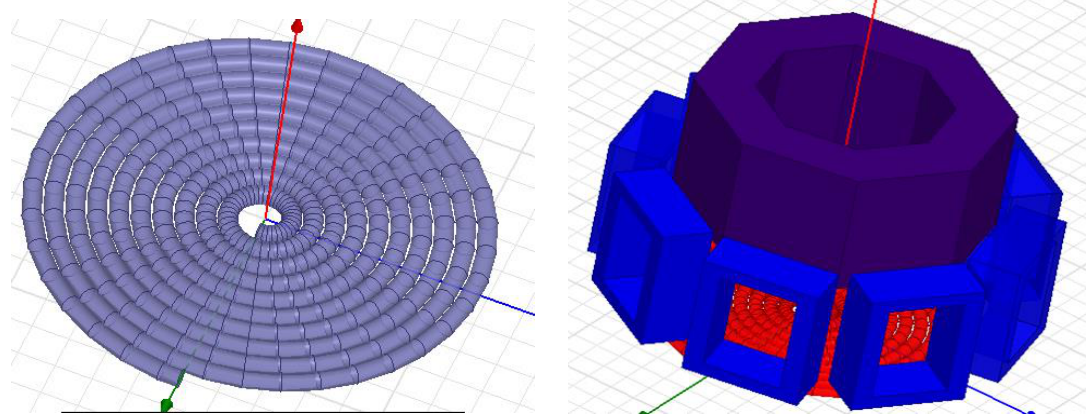
Figure 5. Arrangement of spiral catapult coil and MFEML with sprial catapult